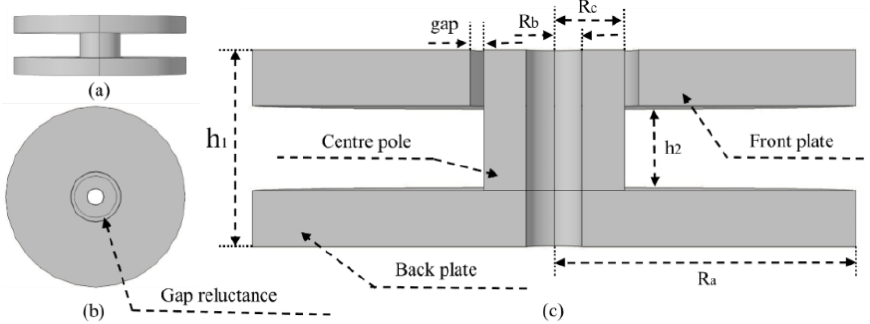
Figure 3. Loudspeaker structure (unit: mm). ( a ) front view, ( b ) top view, and ( c ) loudspeaker cross-section. Table 1. Details of the size of the woofer and tweeter (unit: mm).